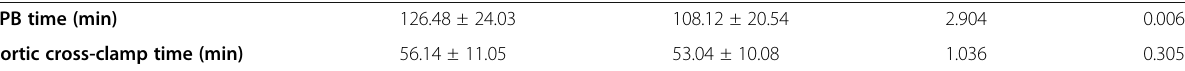
Table 2 CPB and aortic cross-clamp